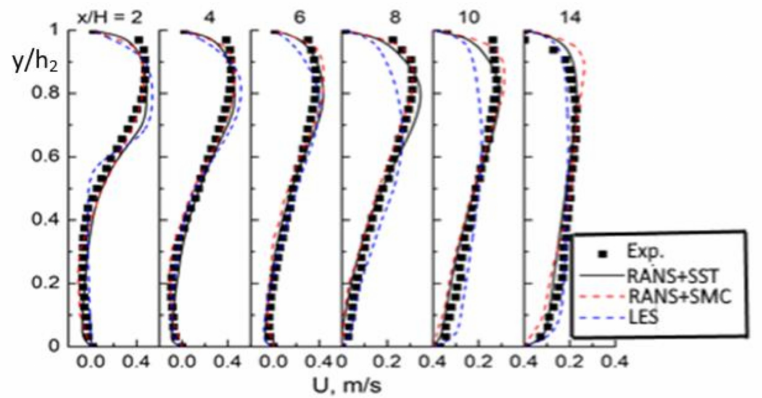
Figure 9. The transverse profiles of single-phase mean longitudinal velocity behind a backward- facing step. Symbols and curves are the authors’ measurements and predictions, respectively. Re H = 6600, ER =